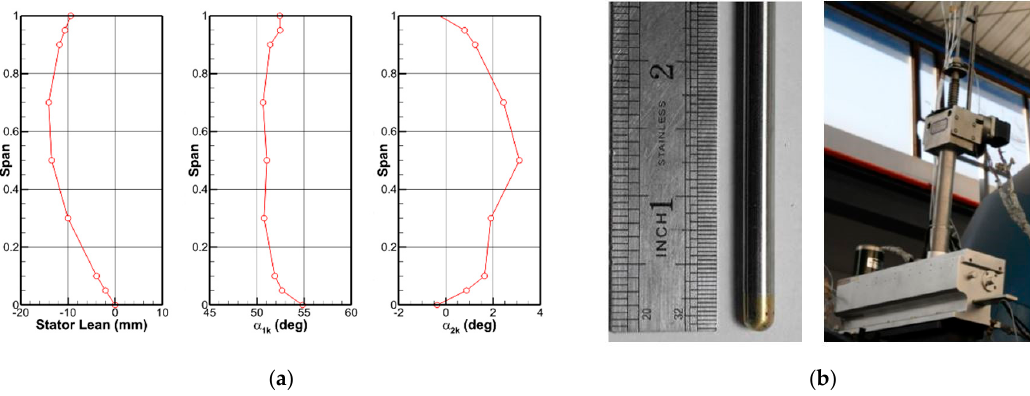
Figure 2. Stator blade and blade profile : ( a ) pictorial view of stator blade; ( b ) profile configurations at three typical blade spans.